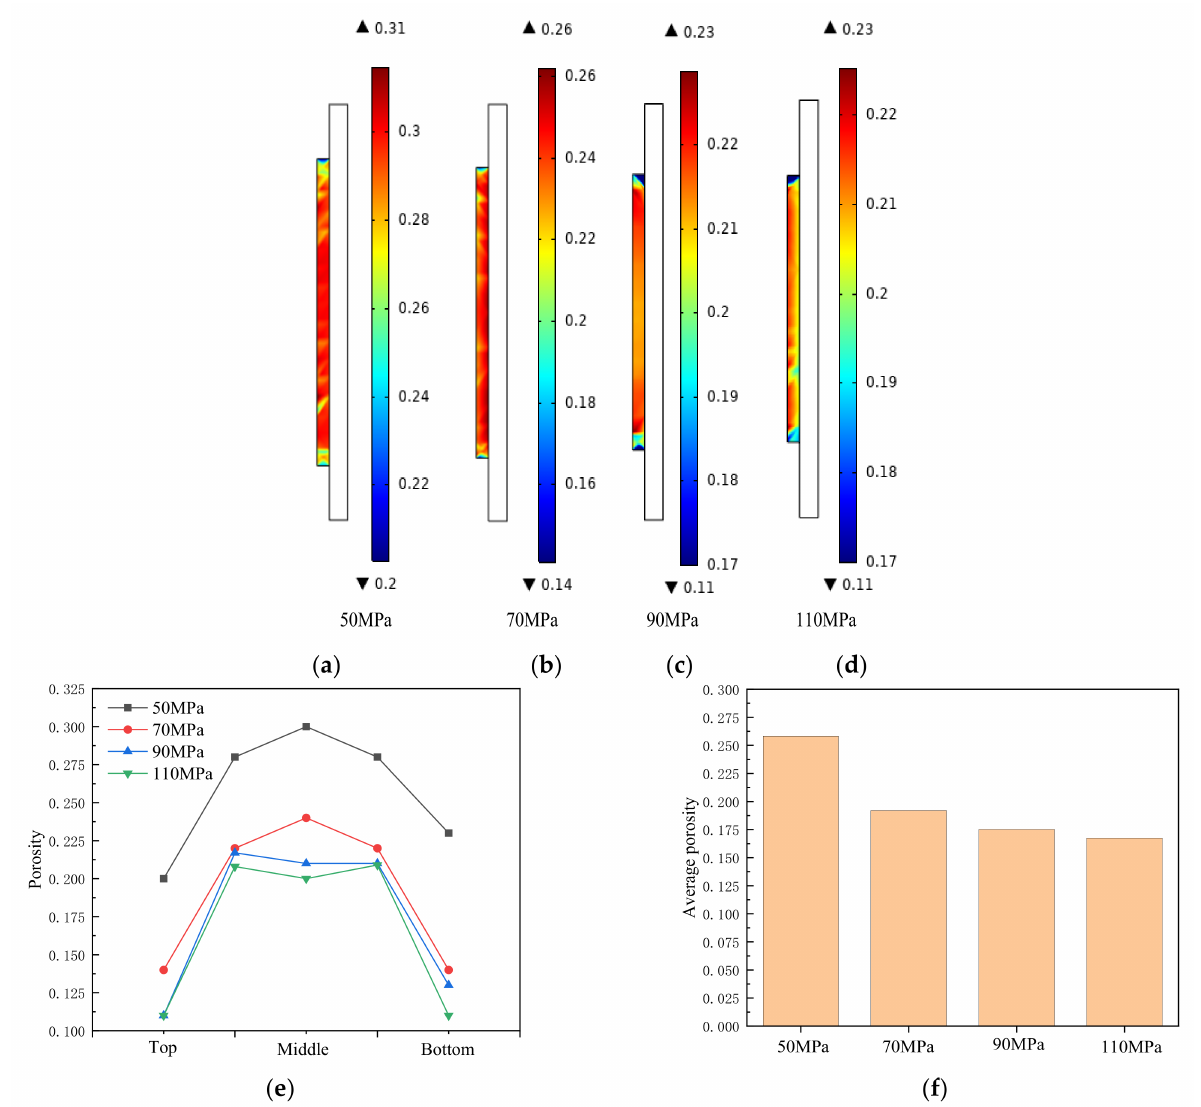
Figure 3. Influence of sintering pressure on porosity of sintered sample at 950 ◦ C: ( a ) 50 MPa; ( b ) 70 MPa; ( c ) 90 MPa; ( d ) 110 MPa; ( e ) porosity distribution under different pressures at 950 ◦ C; ( f ) average porosity under different pressures at 950 ◦